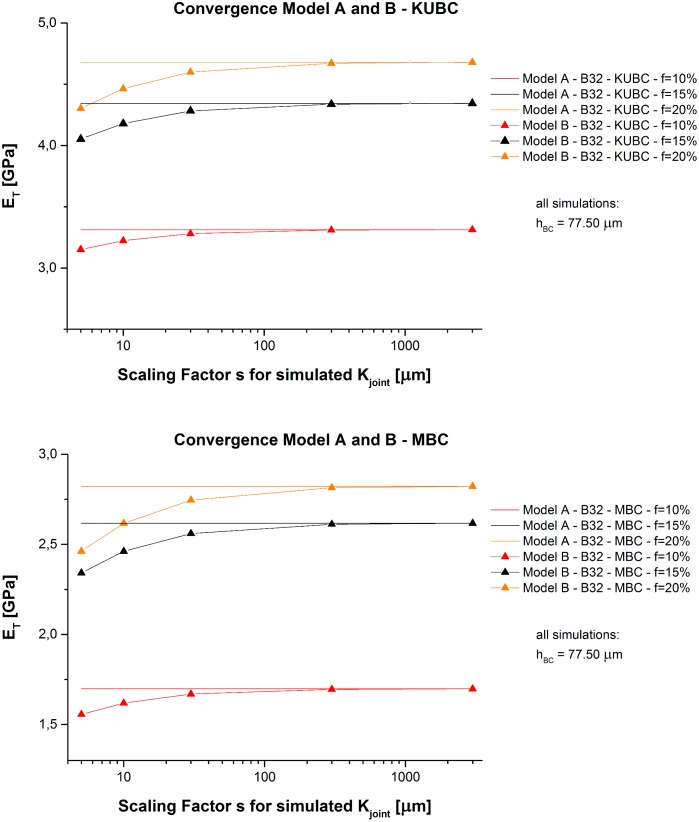
Model A and B—Convergence of results.Obtained E
T values of Model A and Model B depending on s.